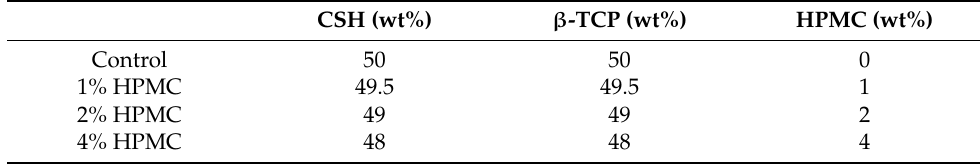
Table 1. Composition and powder content of premixed